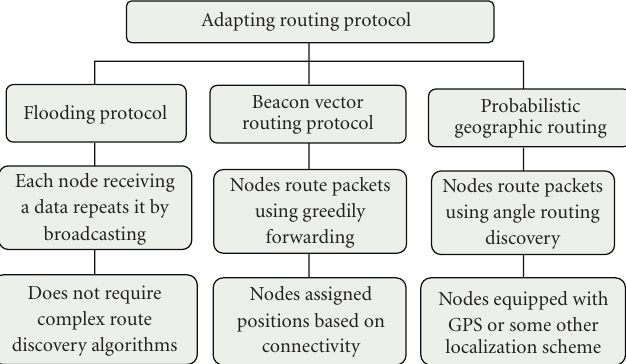
Figure 1: Selected routing protocols for scalability evaluation.